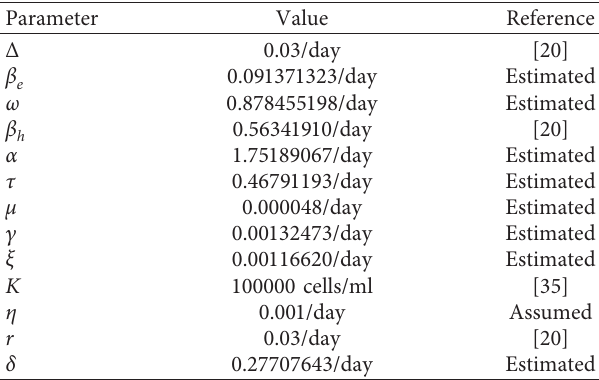
Table 2: The parameter values that give the best fit to the data in the model.